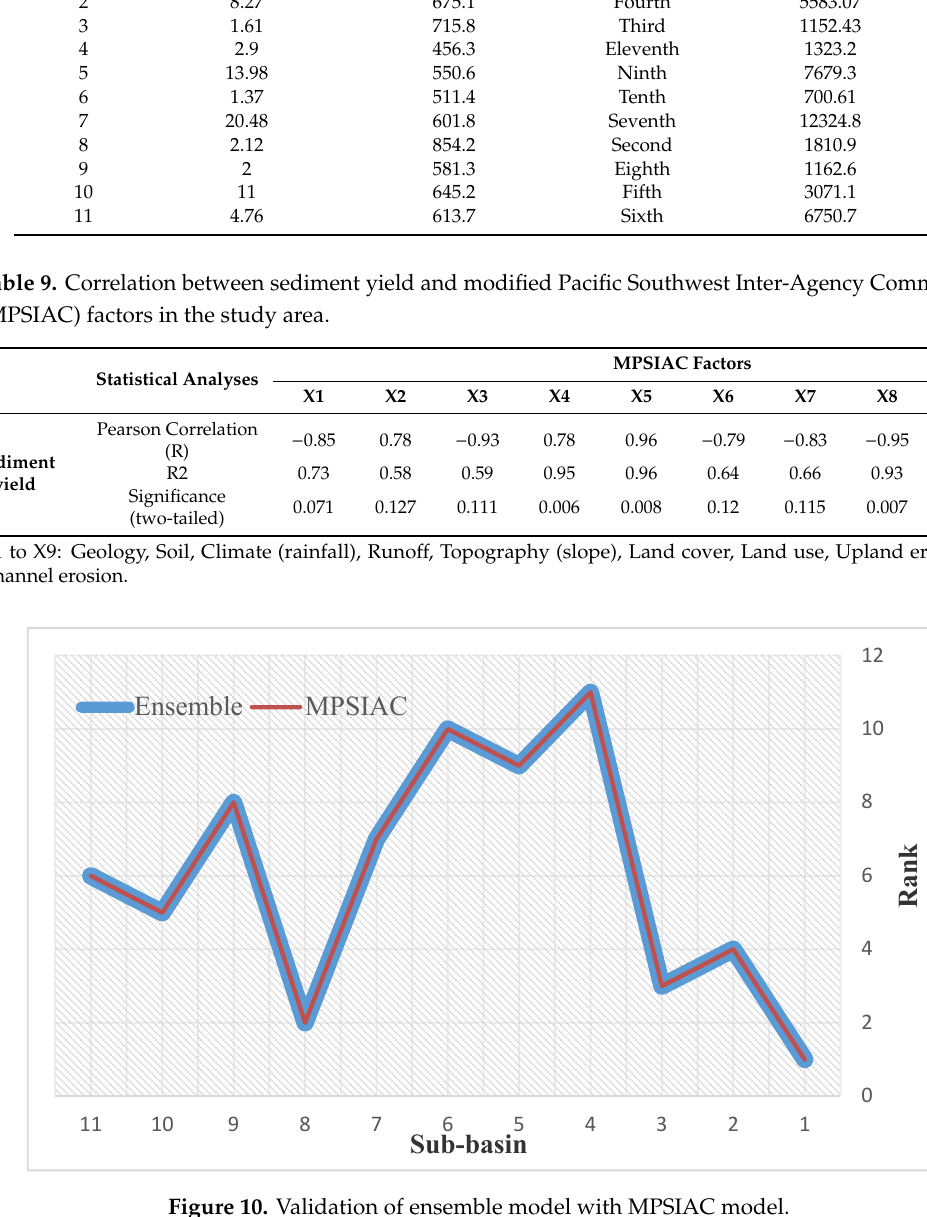
Figure 9. Prioritization of sub ‐ basins for conservation programs.